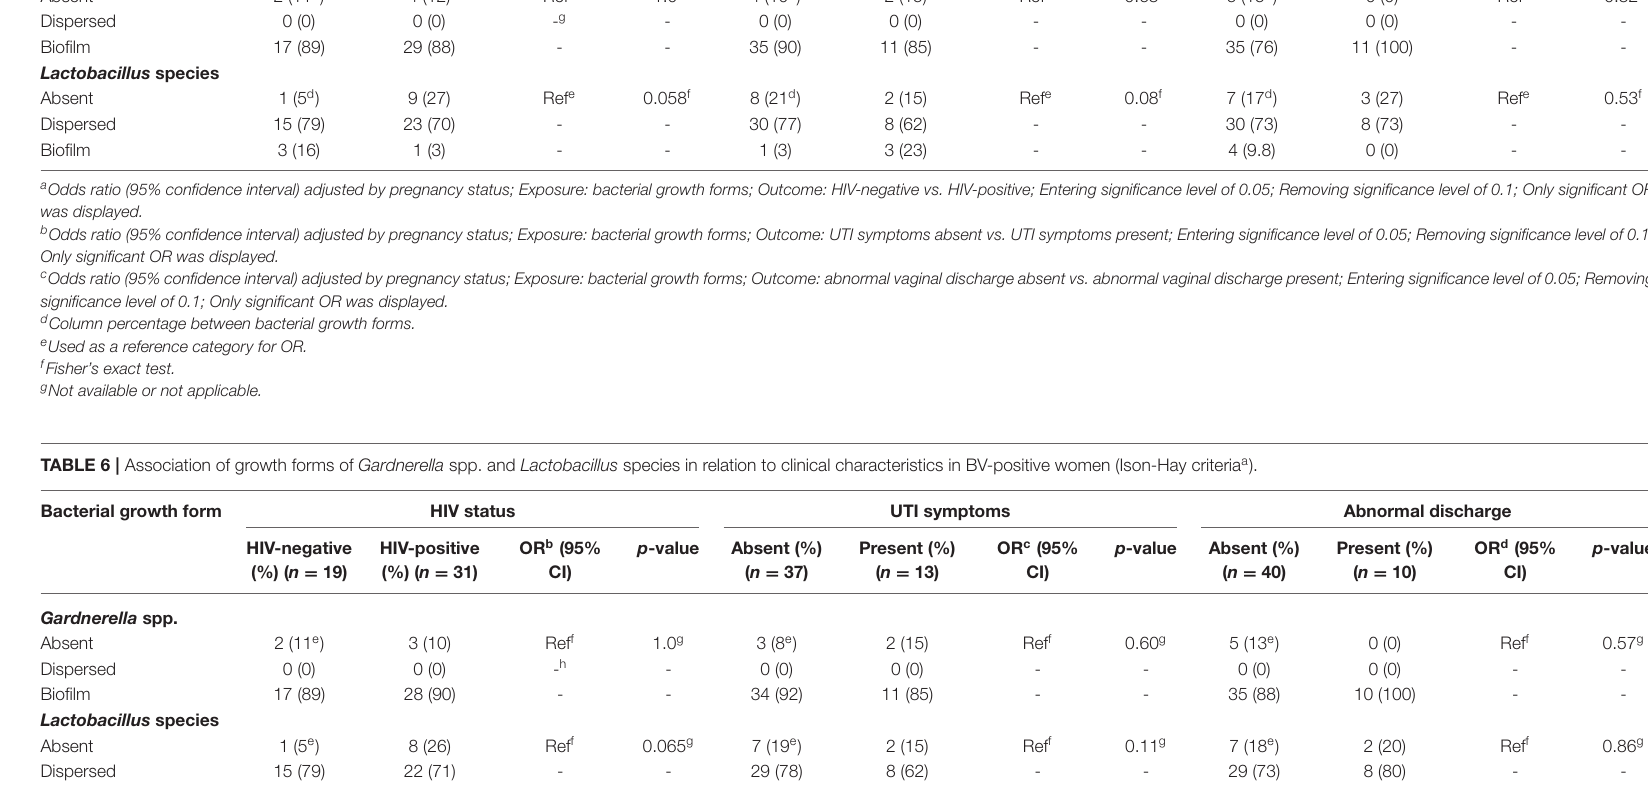
- - 1 (3) 3 (23) - - 4 (10) 0 (0) - - a Class IV and 0 omitted for comparison with Nugent scoring. b Odds ratio (95% confidence interval) adjusted by pregnancy status; Exposure: bacterial growth forms; outcome: HIV-negative vs. HIV-positive; Entering significance level of 0.05; Removing significance level of 0.1; only significant OR was displayed. c Odds ratio (95% confidence interval) adjusted by pregnancy status; Exposure: bacterial growth forms; outcome: UTI symptoms absent vs. UTI symptoms present; Entering significance level of 0.05; Removing significance level of 0.1; only significant OR was displayed. d Odds ratio (95% confidence interval) adjusted by pregnancy status; Exposure: bacterial growth forms; outcome: abnormal vaginal discharge absent vs. abnormal vaginal discharge present; Entering significance level of 0.05; Removing significance level of 0.1; only significant OR was displayed. e Column percentage between bacterial growth forms. f Used as reference category for OR. g Fisher’s exact test. h Not available or not